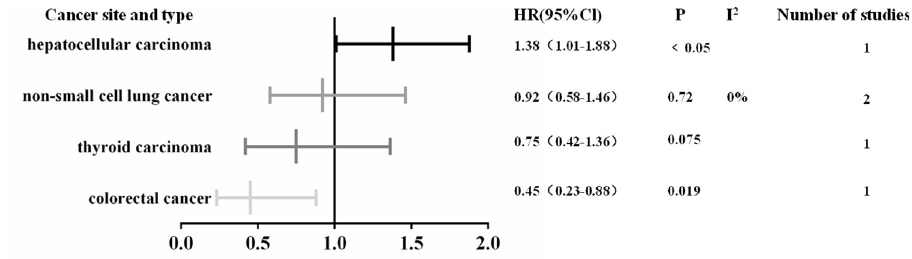
Fig 6. Summary risk estimates of DFS by cancer sites.